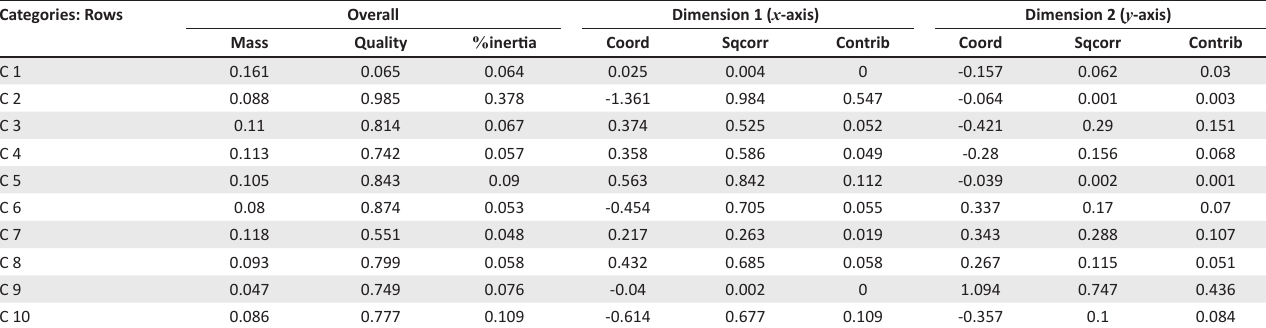
Table 1-A3 represents the statistics relating to the accounting policy themes (columns) in the correspondence table. Each accounting policy has a coordinate in both Dimension 1 and Dimension 2, with the contribution (‘contrib’) showing the relative strength of the accounting policy to the overall relationship. A higher contribution indicates a greater strength and, therefore, increasing statistical significance. TABLE 1-A3: Statistics for accounting policy